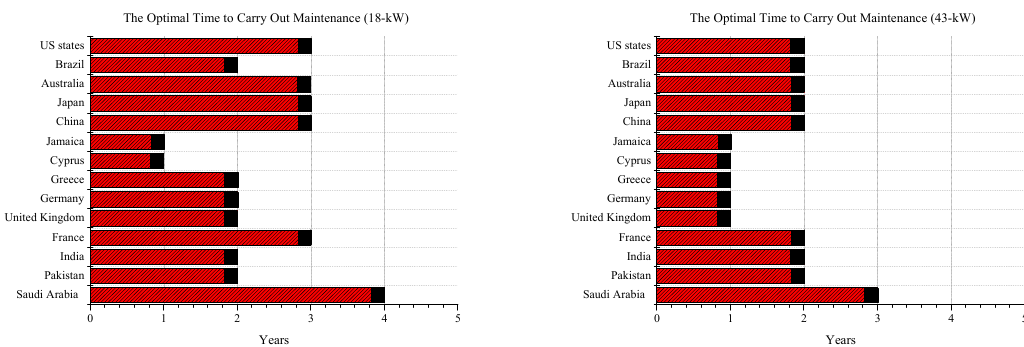
Figure 15. The year identified by the suggested algorithm as the optimal time to carry out maintenance in order to achieve the greatest economic advantage.